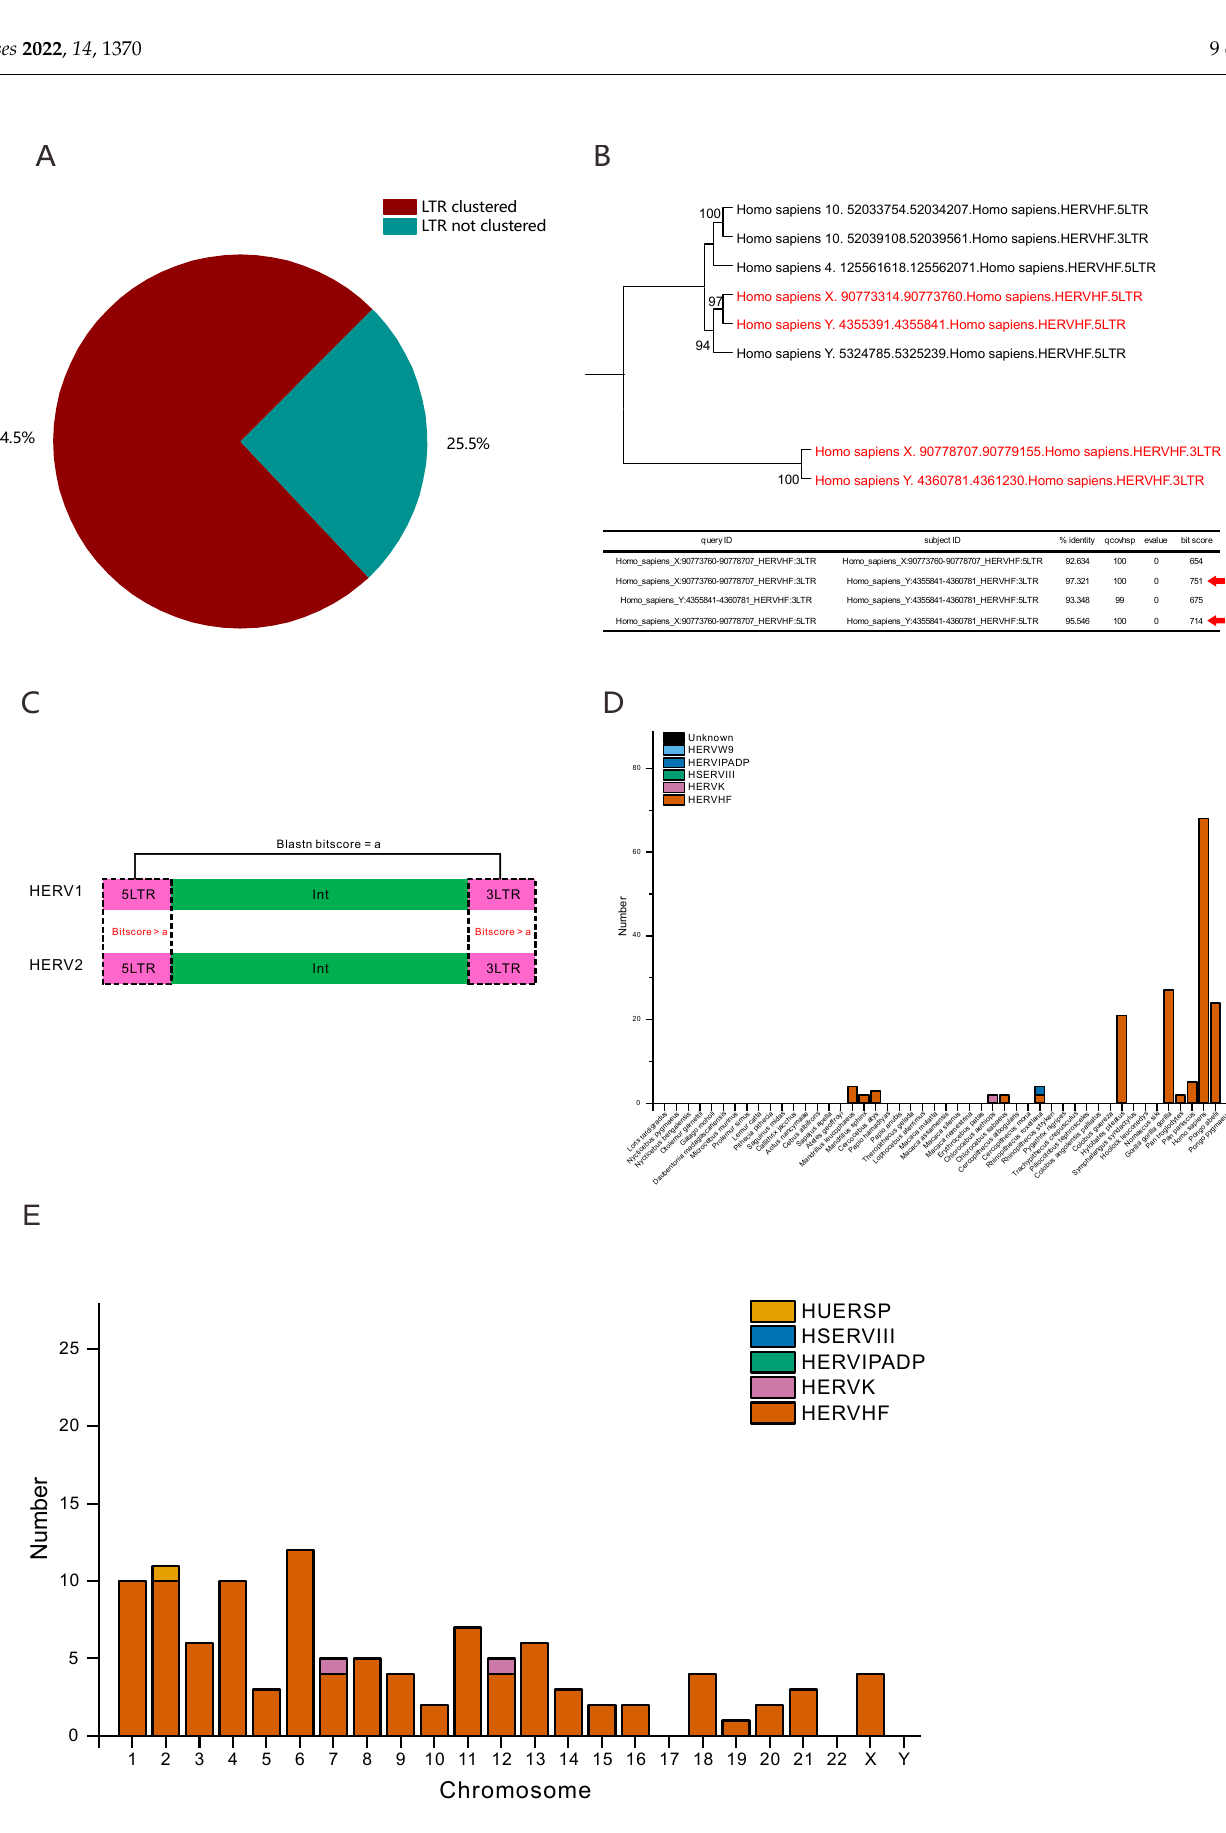
Figure 2. F-HERVs may be involved in host genomic recombination or transcribed into ncRNAs. ( A ) The pie chart shows the number of F-HERVs with clustered LTRs (dark red) and HERVs with